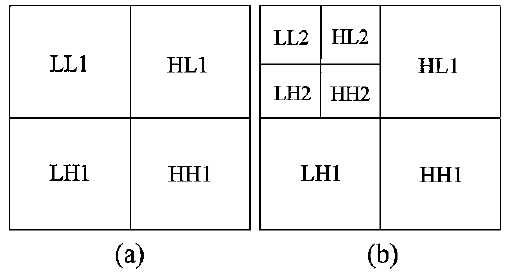
Figure 1. Image decomposition using DWT: (a) Level 1, (b) Level 2.